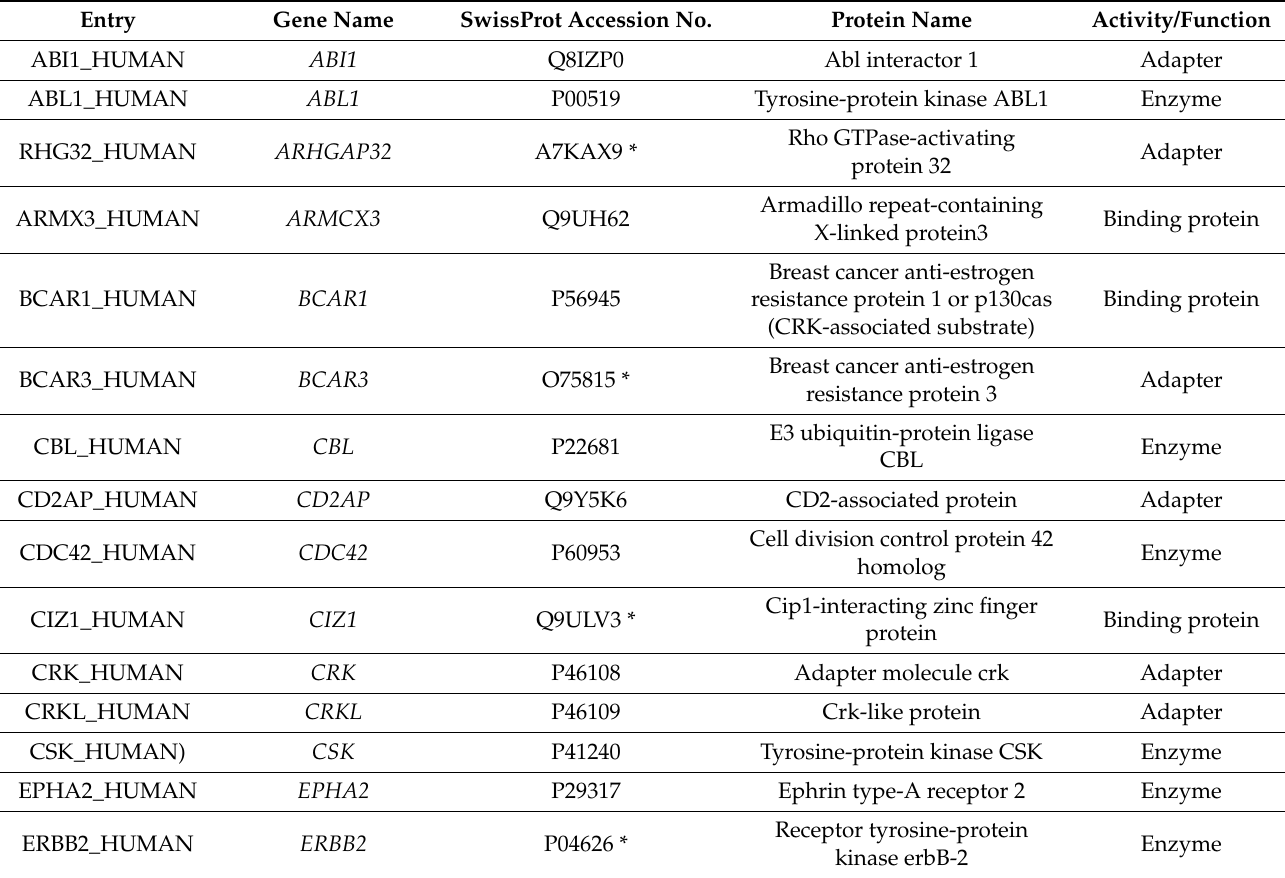
Table 1. List of selected proteins. The selected proteins were detected in both cell lines or in MCF-7 cells only (marked by *) or in FTC-133 cells only (marked by